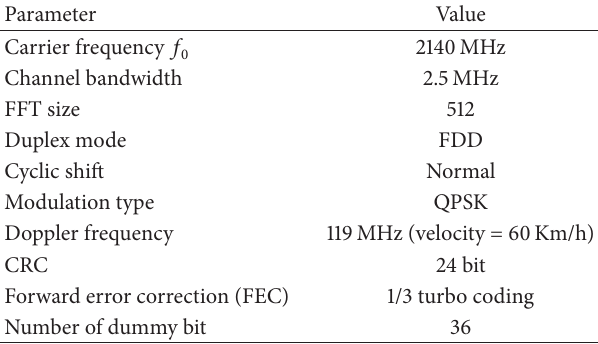
Table 2: Parameters of the computer simulations.